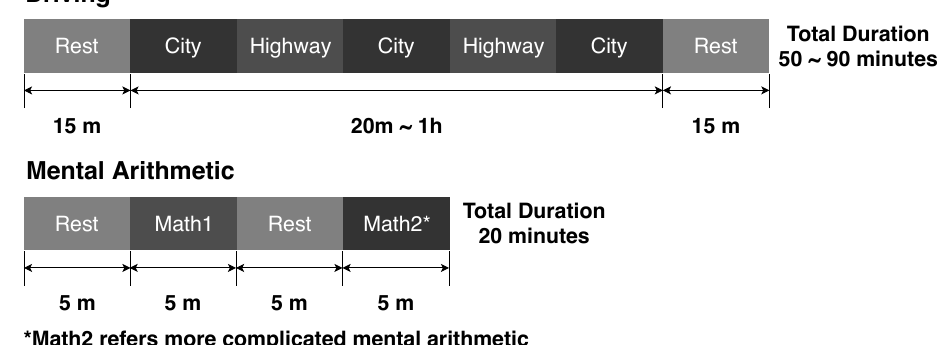
Figure 1. The experimental procedures and their